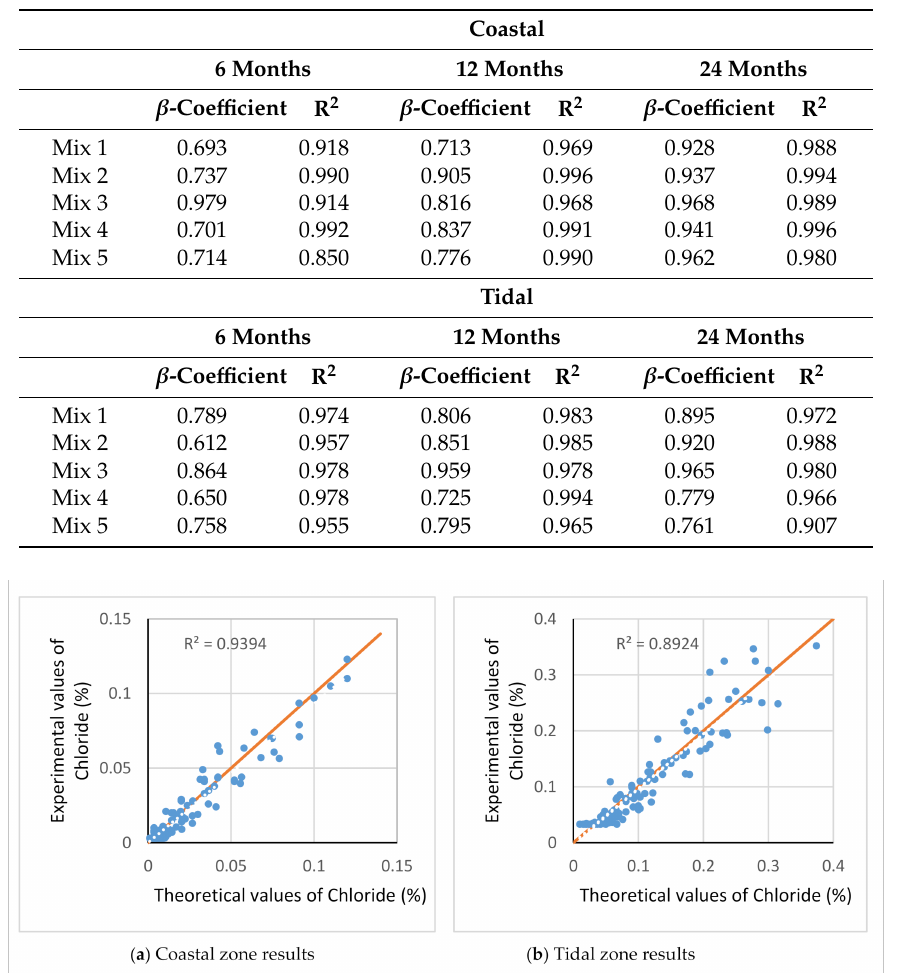
Table 2. Statistical analysis results.